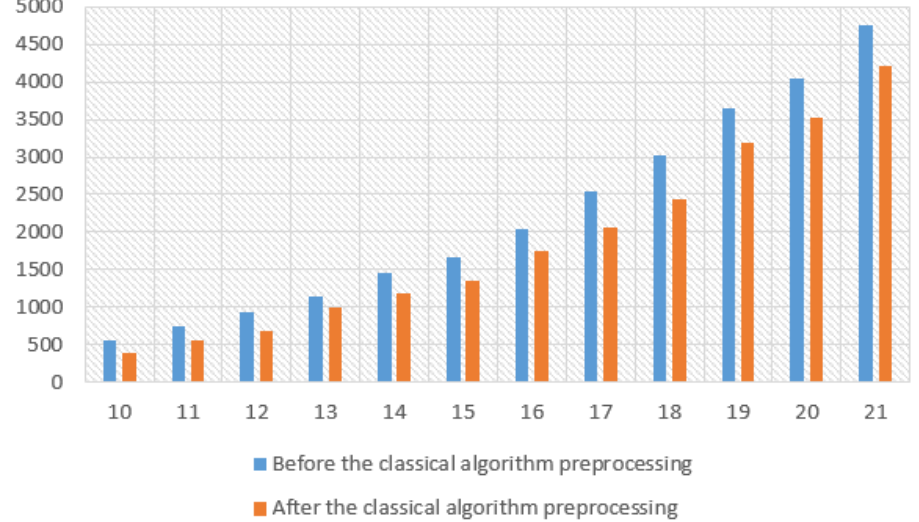
Figure 8. Changes in the number of Boolean equations before and after preprocessing with a classical algorithm.